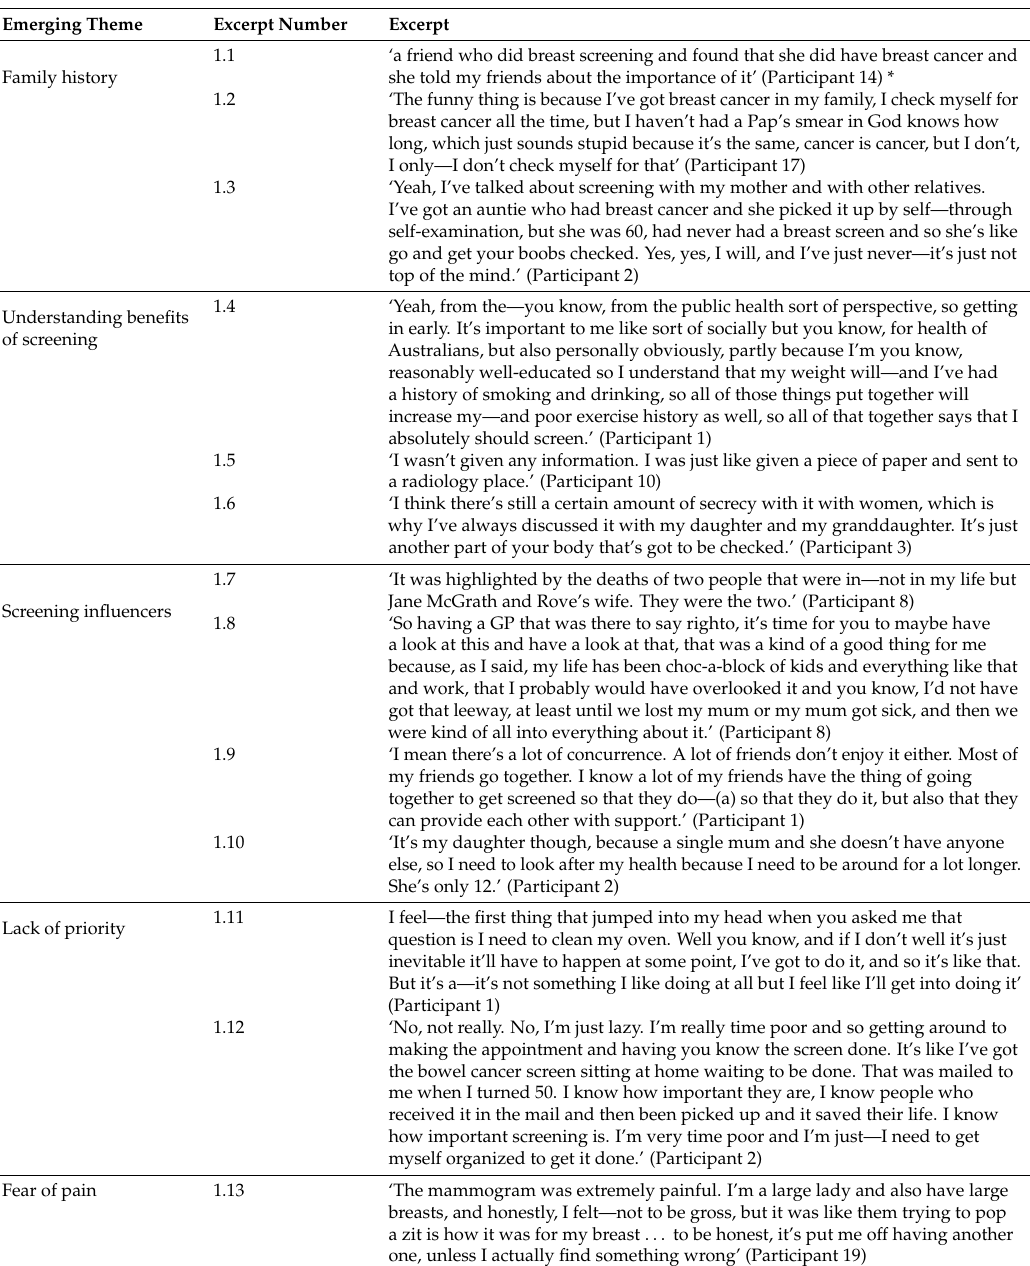
Table 3. Obese women’s understanding and awareness of screening can affect